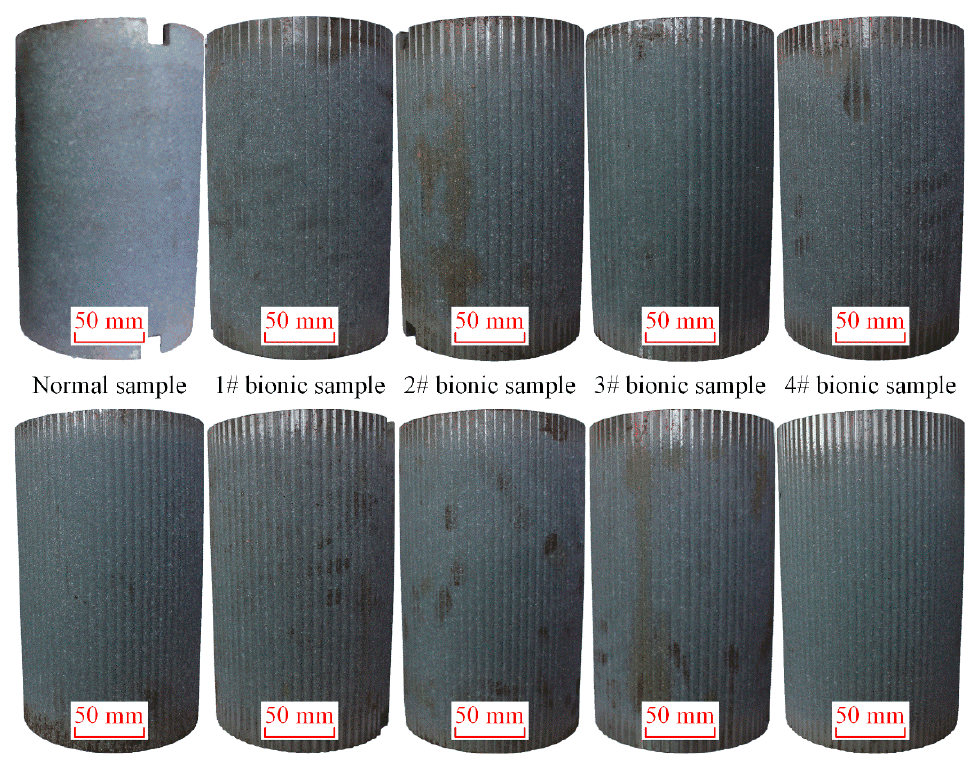
Figure 4. Worn grinding rollers.